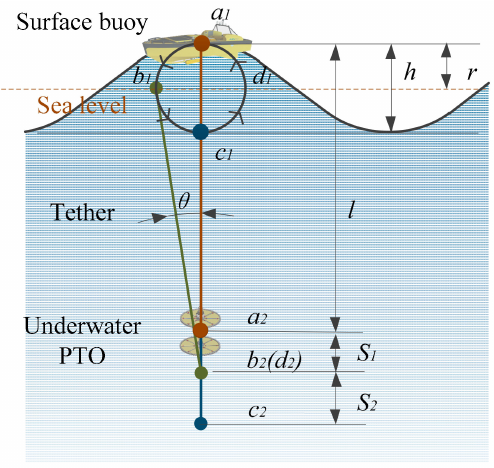
Figure 11. Schematic diagram of the relationship between wave motion and WEC [32]. Adapted from [32], with permission from MDPI,